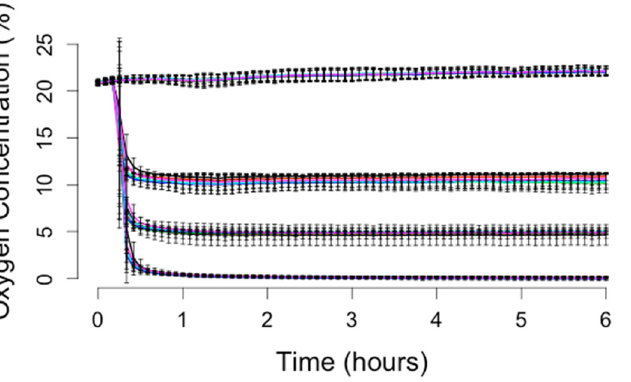
Fig 2. Oxygen Characterization. Time course data of four oxygen conditions are demonstrated in a 24-well plate. Each 6-well row of the plate can be controlled independently. Error bars are the standard deviation N =